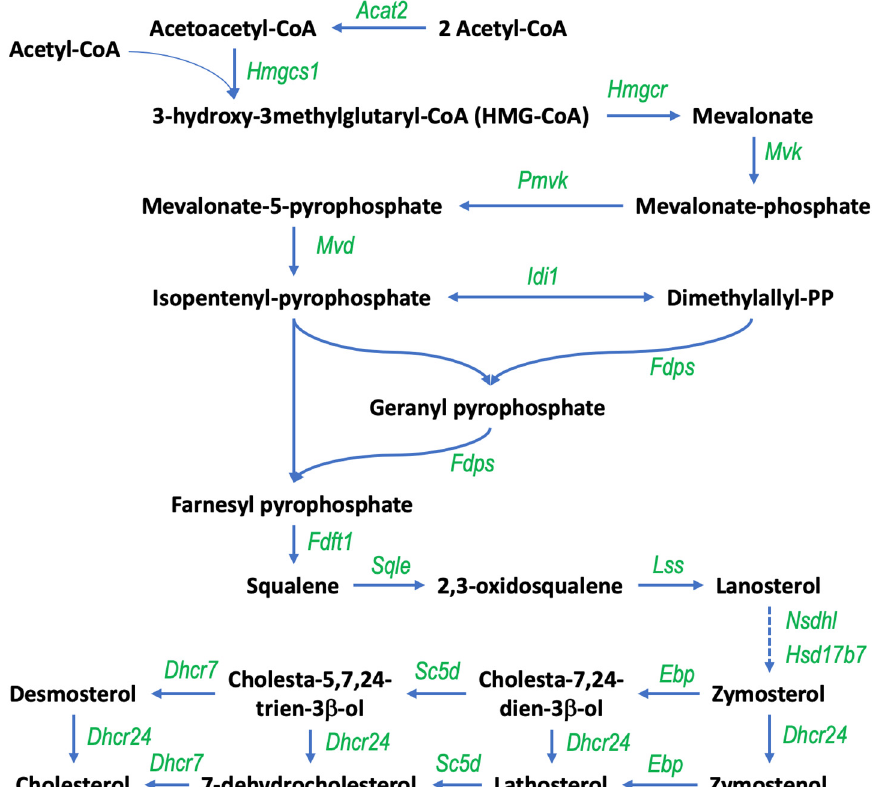
Figure 12. Gigantol increases the expression of genes involved in the biosynthesis of cholesterol in MA-10 Leydig cells. Uses of NADPH molecules are not shown. Abbreviations: Acat2, Acetoacetyl-CoA thiolase; Hmgcs1, HMG-CoA synthase; Hmgcr, HMG-CoA reductase; Mvk, mevalonate kinase; Pmvk, Phosphomevalonate kinase; Mvd, Mevalonate diphosphate decarboxylase; Idi1, Isopentenyl pyrophosphate isomerase; Fdps, Farnesyl pyrophosphate synthase; Fdft1, Squalene synthase; Sqle, Squalene monooxygenase; Lss, Lanosterol synthase; Nsdhl, NAD(P) dependent steroid dehydrogenase-like; Hsd17b7, Hydroxysteroid 17-beta dehydrogenase 7; Dhcr24, 24-Dehydrocholesterol reductase; Ebp, Cholestenol delta-isomerase; Sc5d, Sterol-C5-desaturase; Dhcr7, 7-Dehydrocholesterol reductase.